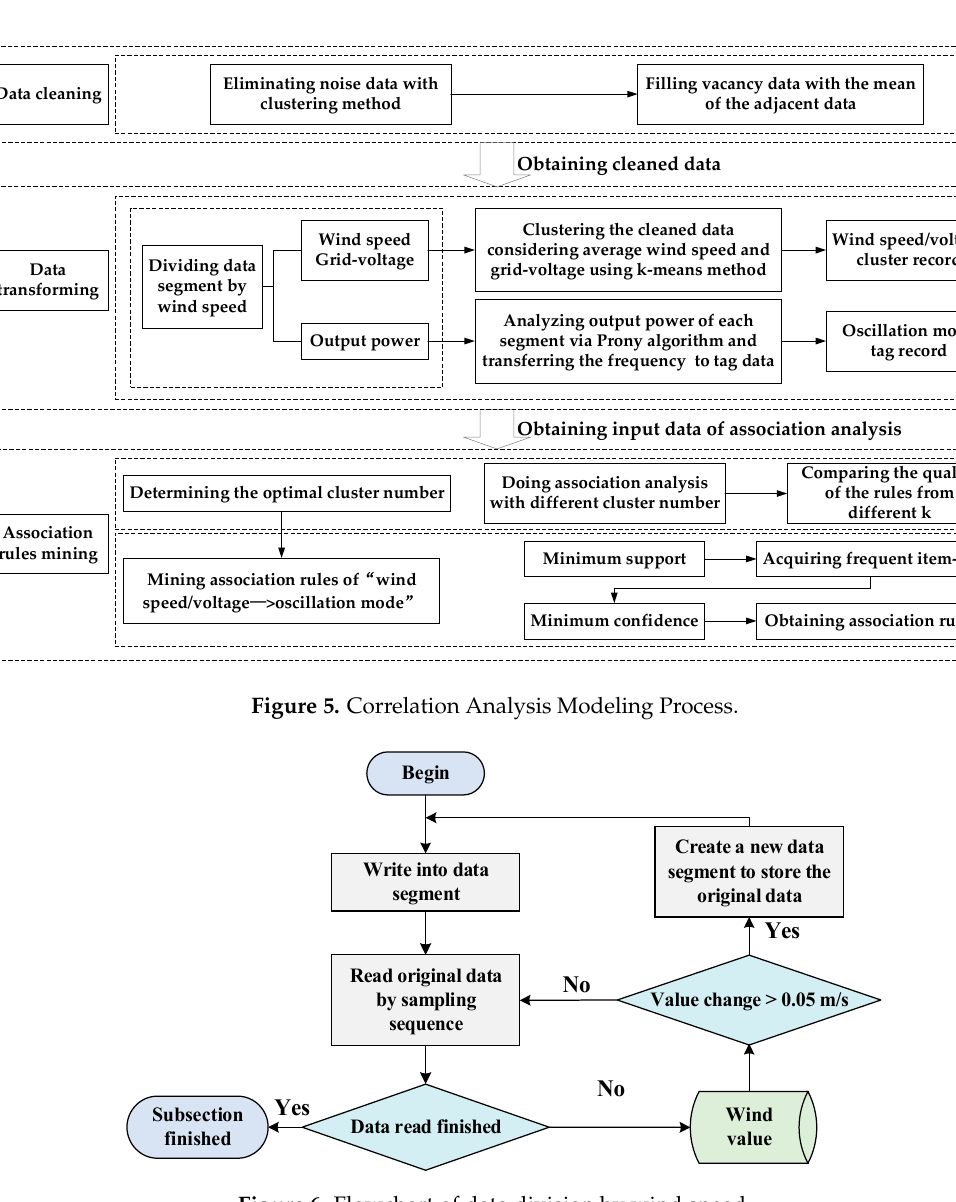
Figure 6. Flowchart of data division by wind speed.